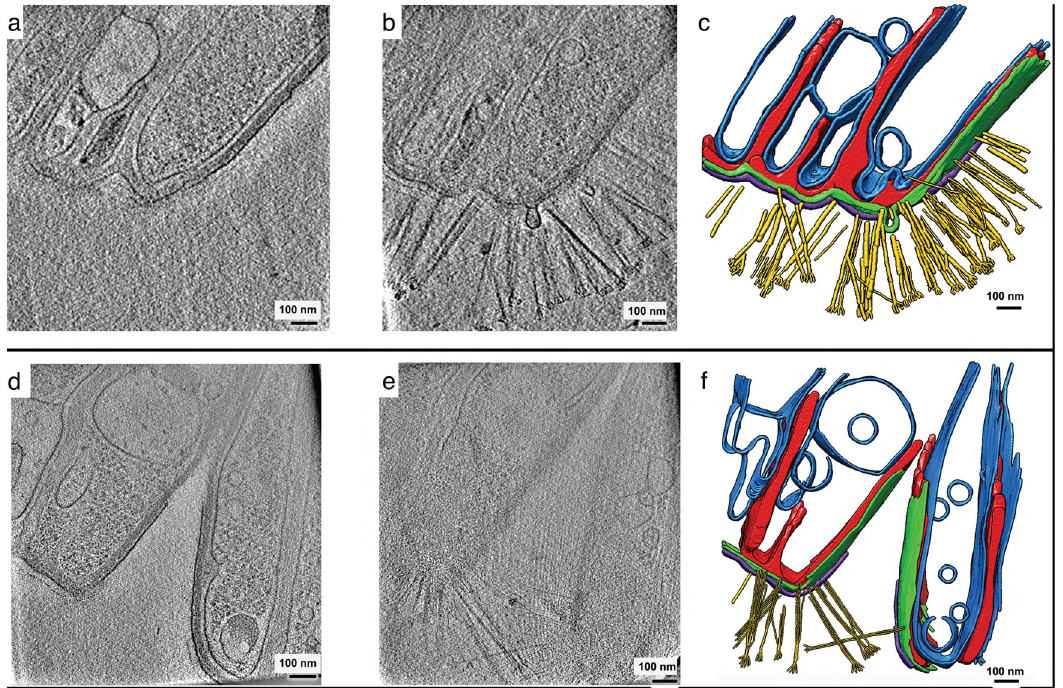
Fig. 6 | CryoET reveals the three-dimensional architecture of RBS-A compo- nents. a , b , d , e Examples of ~3-nm-thick slices at two different depths ( a versus b , d versus e ) from each of two representative RBS-A tomograms. c , f Corresponding manual annotations of cellular features. The tomograms are